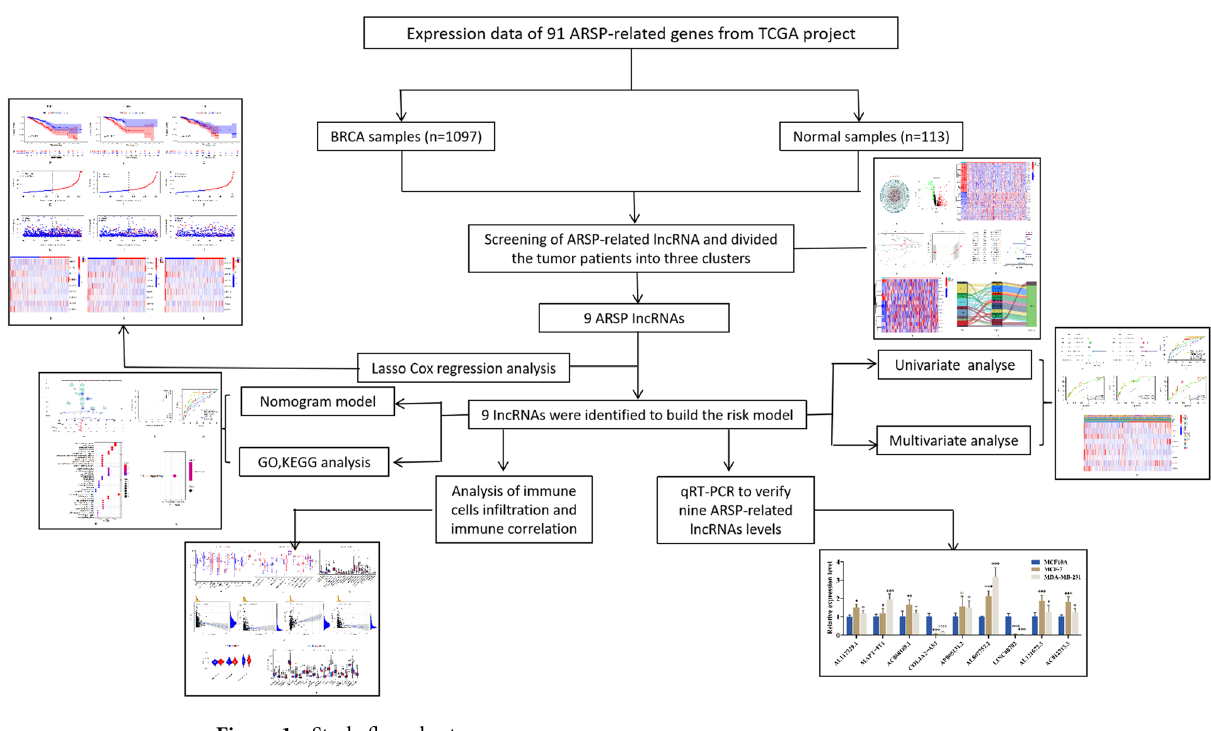
Figure 1. Study flow